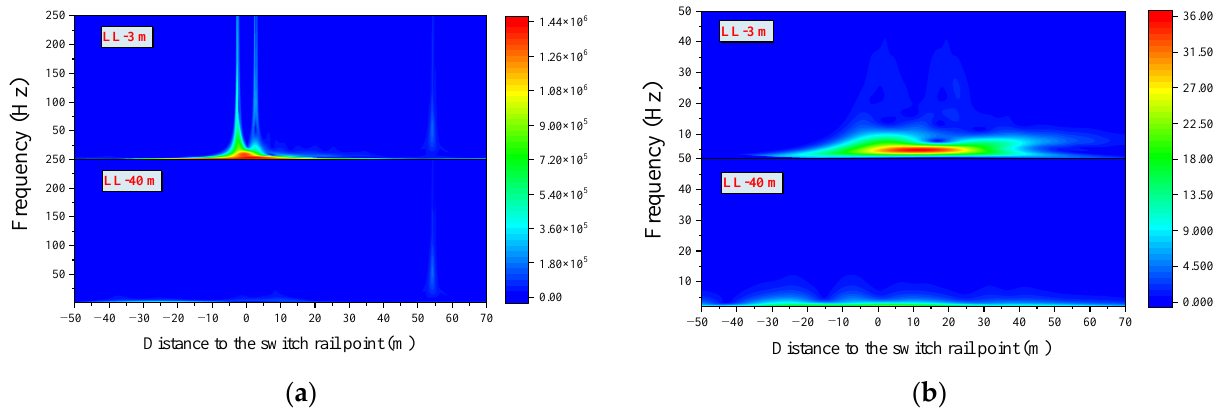
Figure 15. Time-frequency graphs of dynamic indicators at the LL in front of the turnout: ( a ) Wheel- rail vertical force; ( b ) Vertical acceleration of the vehicle body.